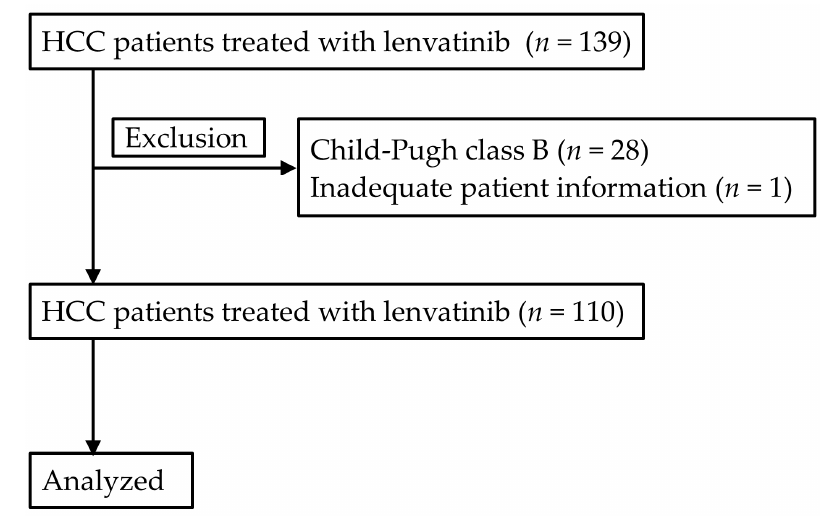
Figure 8. A flowchart of patient selection.